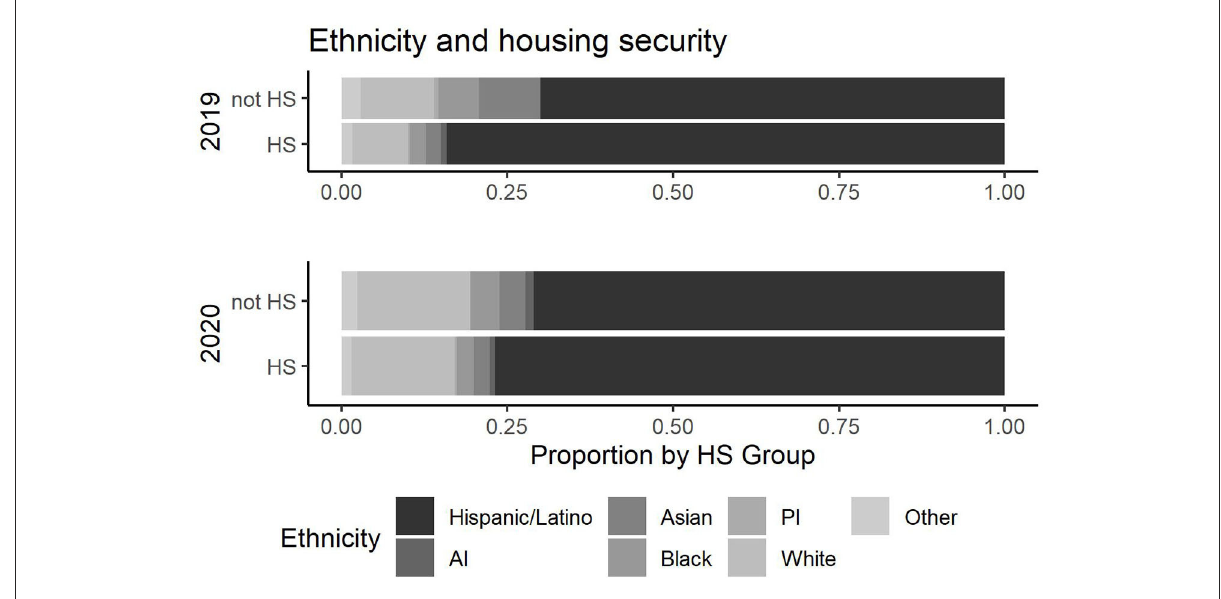
FIGURE8 Ethnicity and housing